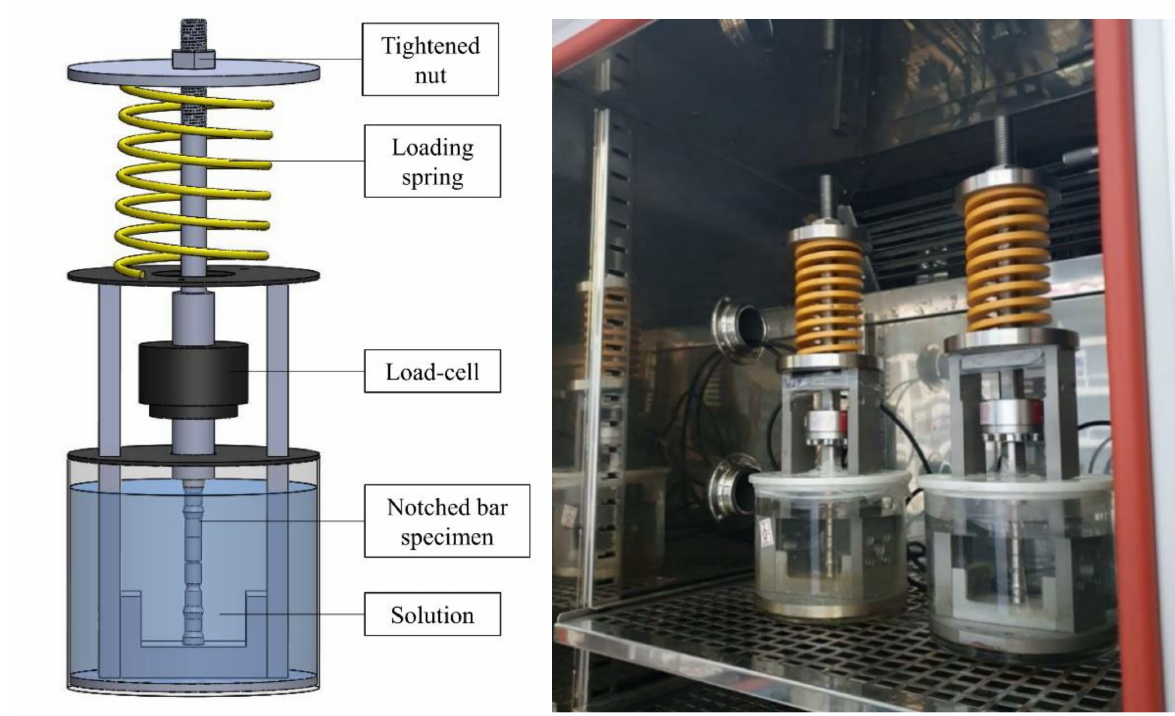
Figure 3. Schematic illustration ( left ) and photograph ( right ) of the notched bar tensile test apparatus.